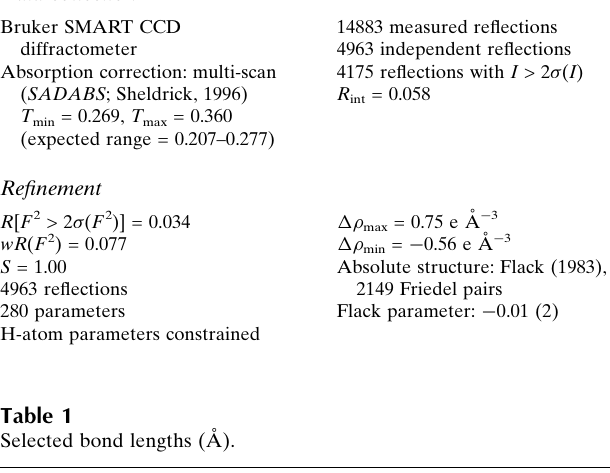
Selected bond lengths (A˚ ).